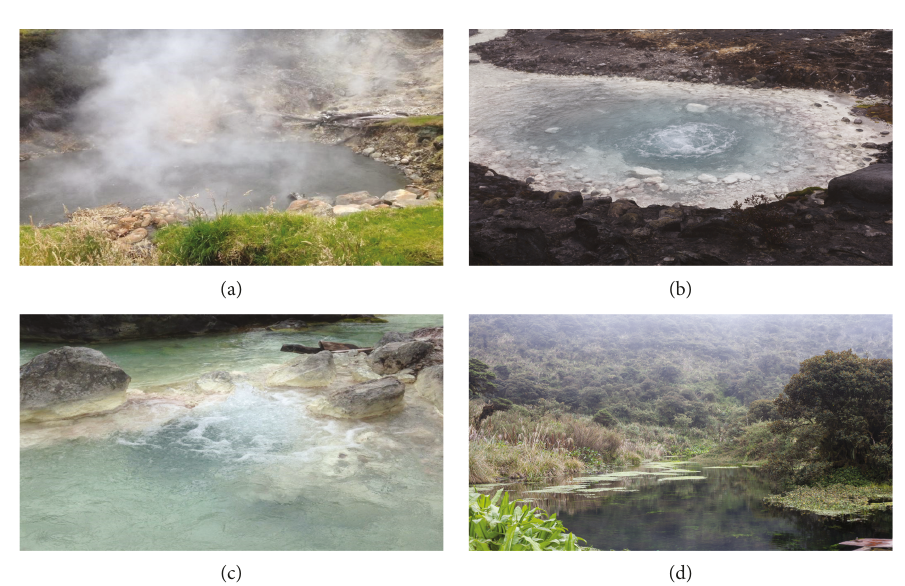
Figure 2: (a) Source Pozo Azul, (b) geyser outcrop 1, (c) geyser outcrop 3, and (d) Perico